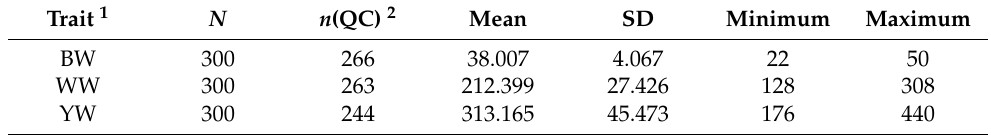
Table 1. Descriptive statistics for studied live weight traits (kg) of Braunvieh cattle. Trait 1 N n (QC) 2 Mean SD